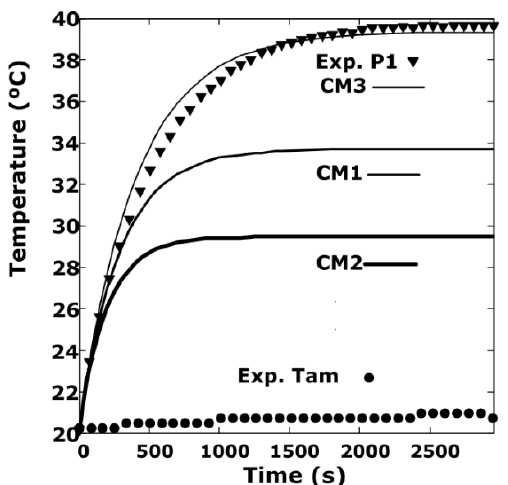
Figure 14. Adjustment of the simulation of the transient regime at point P1, compared to the Figure14. AdjustmentofthesimulationofthetransientregimeatpointP1, comparedtotheexperimental experimental data, CM1, CM and CM3 with d = 3 mm and w r = 16.12 rad/s. The ambient temperature data, CM1, CM and CM3 with d = 3 mm and w r = 16.12 rad / s. The ambient temperature –Exp.